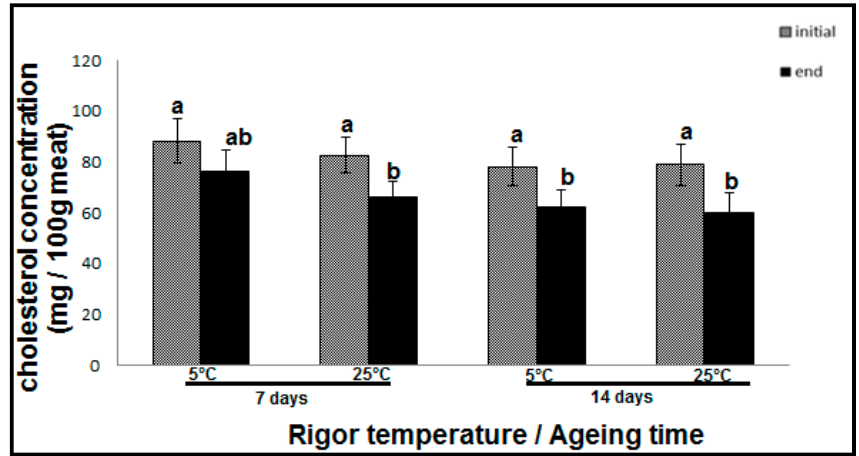
Figure 4. Cholesterol concentrations in hot boned beef SM muscle lipid for samples aged for 7 and 14 days at 2 °C. ab Values with different letters are significantly different at ( p < 0.05). Key: “initial” cholesterol concentrations were determined at the start of display time. The “end” cholesterol concentrations were determined at the completion of 7 days of display time.